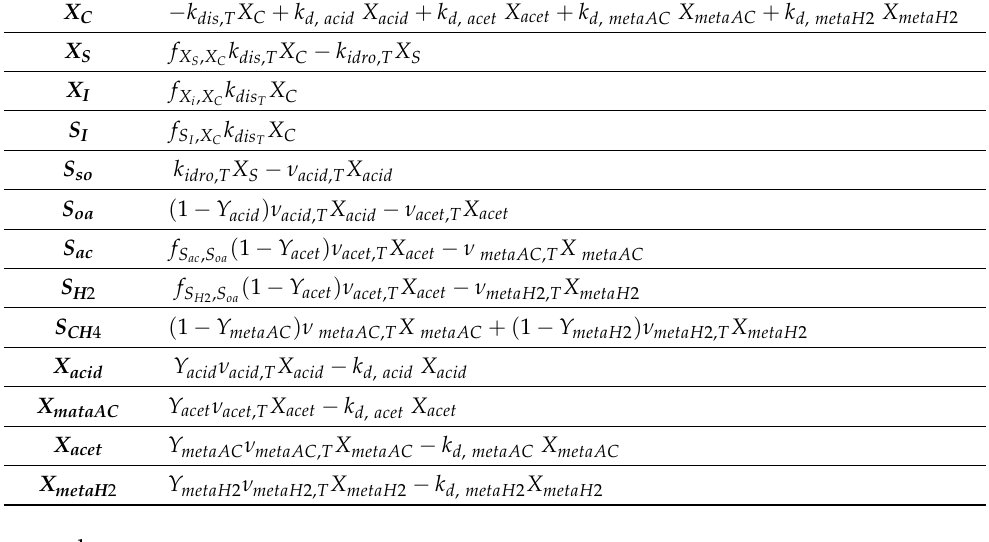
Table 2. Kinetic terms for the different components of